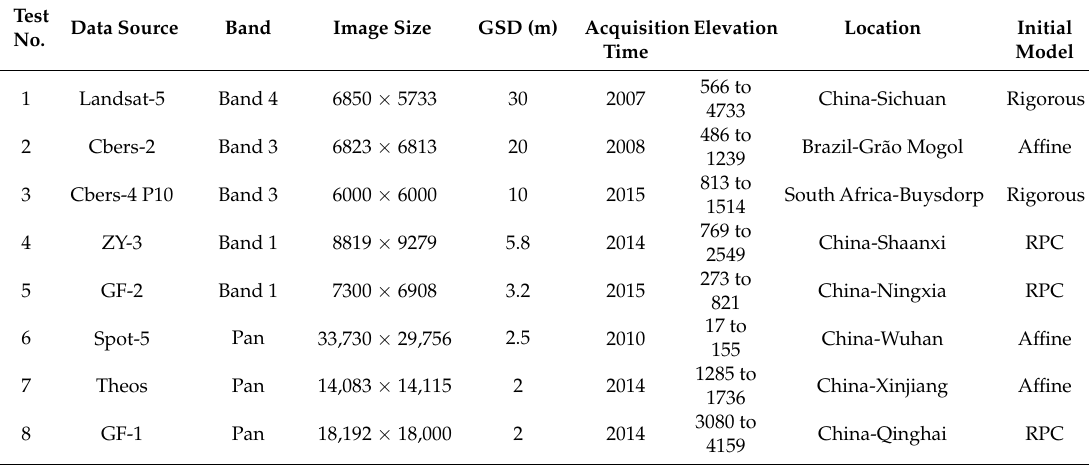
Table 3. General information of the test